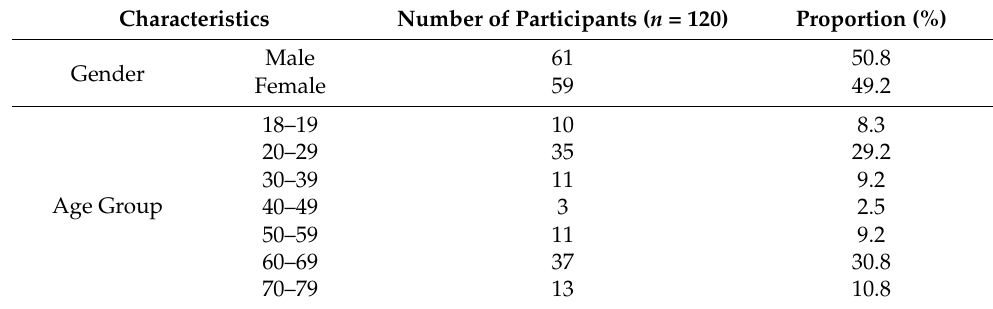
Table 1. Histogram on the age and gender distribution of